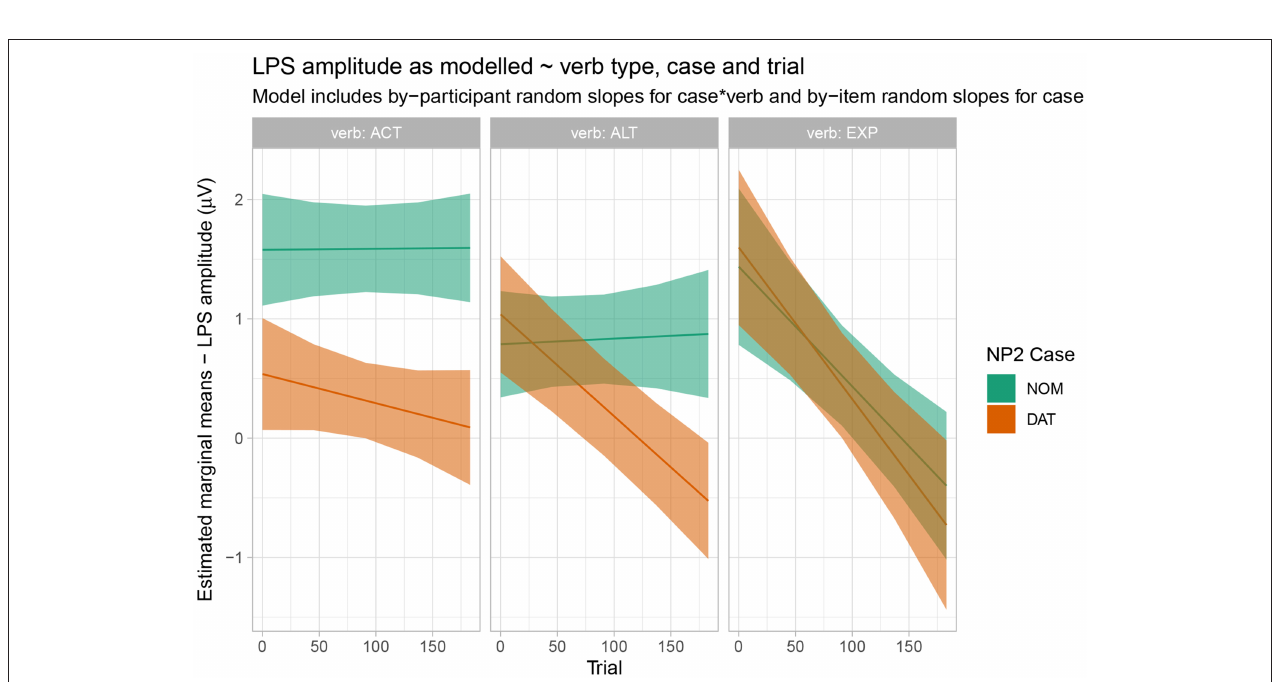
FIGURE 7 | Estimated marginal means for the late positivity time window by verb type, case, and saggitality. Shaded regions indicate 83% confidence intervals.